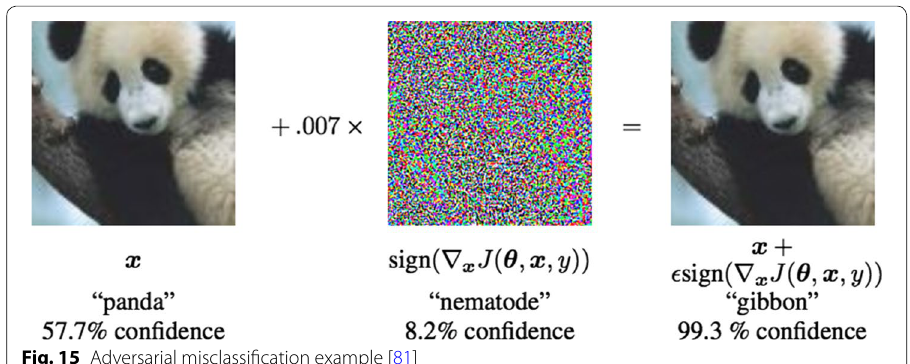
Fig. 15 Adversarial misclassification example